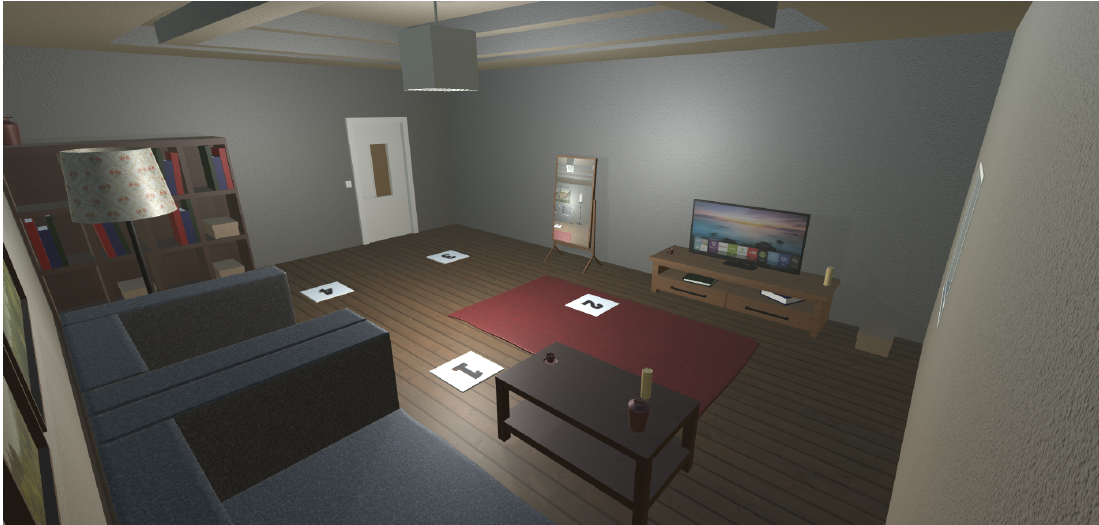
Figure 2. The virtual environment developed for this experiment. The mirror and the indicators on the ground were switched on or off by the experimenter depending on the task at different stages of the